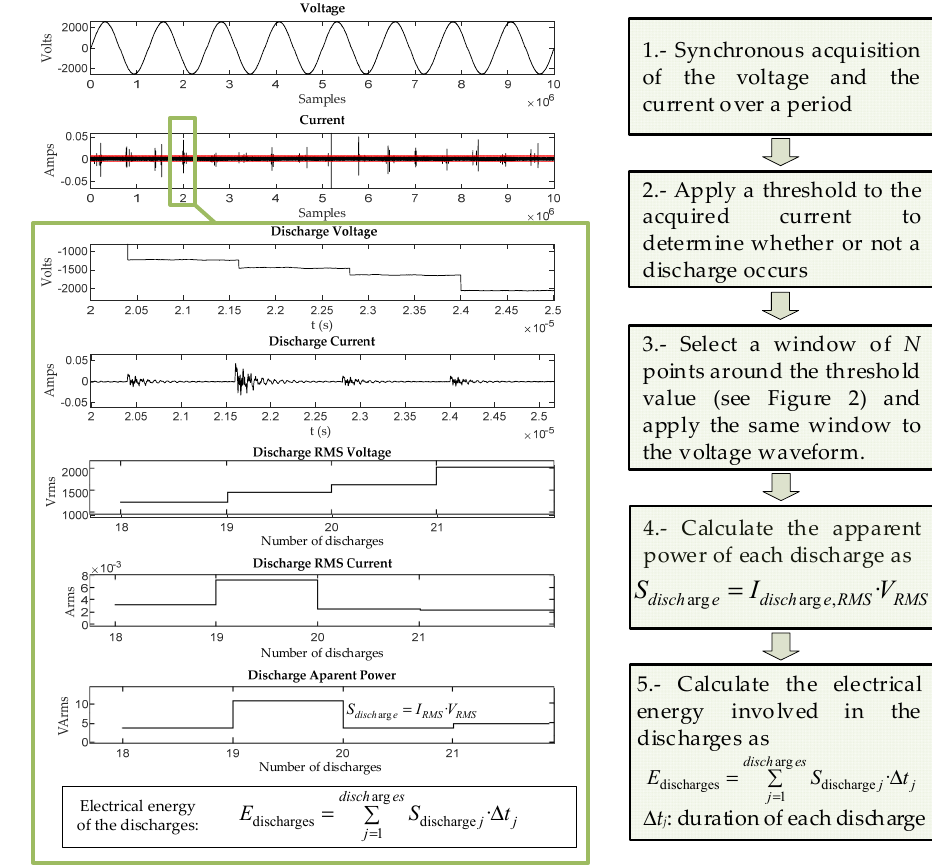
Figure 2. Calculation approach to determine the energy involved in the discharges.